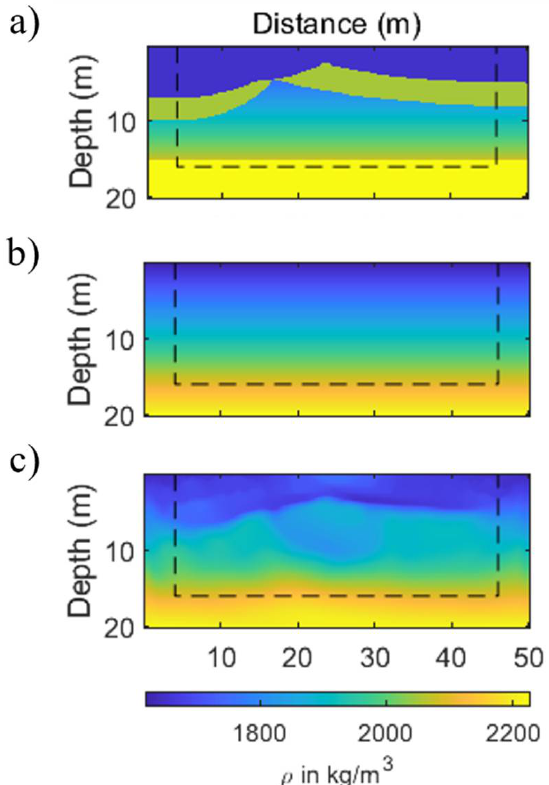
Figure 8. Multi-parameter synthetic example when using a high-frequency source signal: ( a ) the true density model for the calculation of the observed data, ( b ) the initial density model, and ( c ) the inverted density model. The CPML frame is marked by a thin black line.